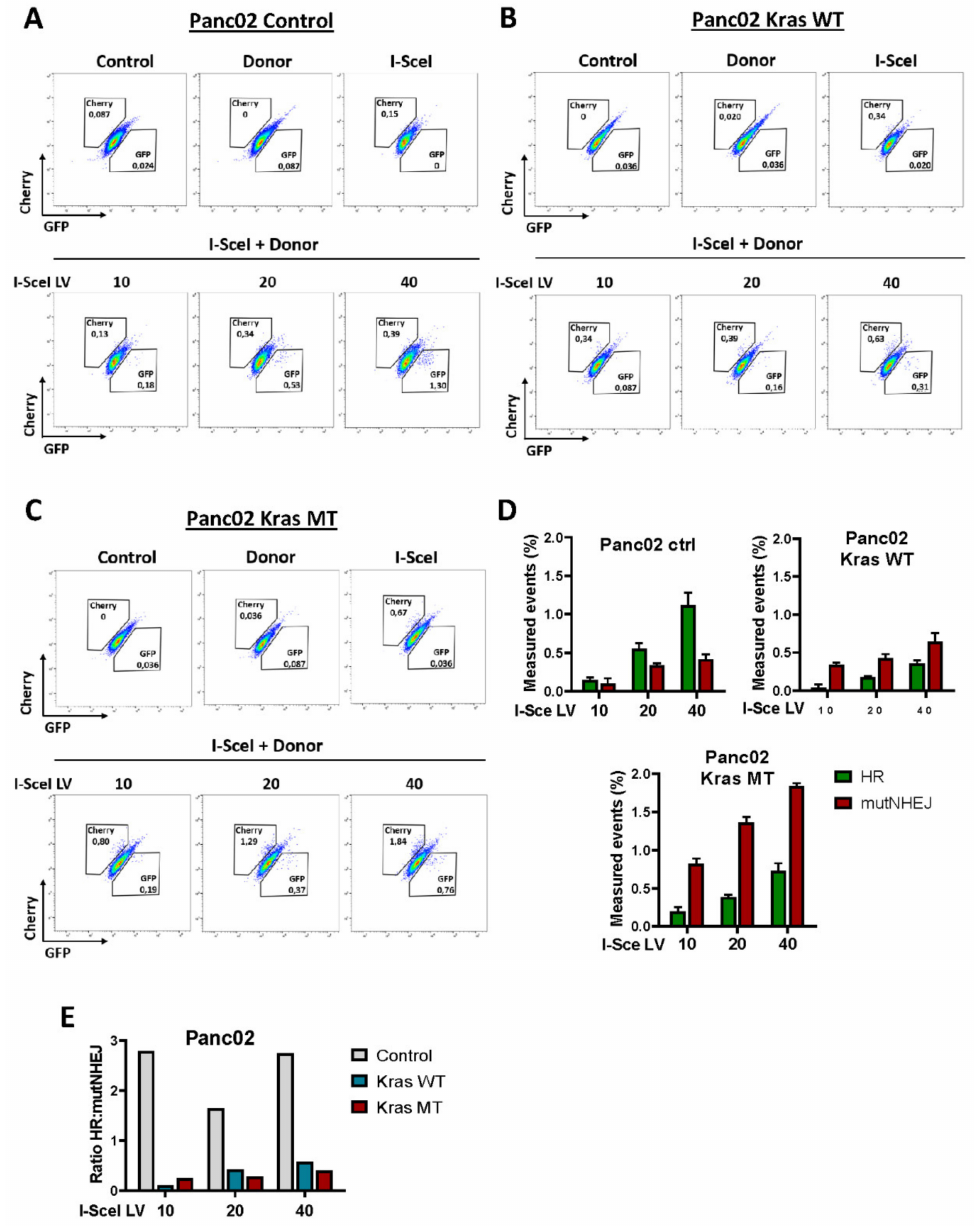
Figure 3. Traffic light reporter assessment of DNA repair fates in mouse pancreatic cancer cell lines. ( A – C ) Representative flow plots following transduction of Panc02 cells with donor and different doses of I-SceI lentivirus (LV) from three independent experiments are shown. Cherry-positive cells indicate a repair event induced by mutNHEJ, and GFP-positive cells represent cells with the HR repair event. ( D ) Quantification of data from all variants of Panc02 cells is presented. Error bars represent mean ± SD. ( E ) Ratio of HR to mutNHEJ based on data in panel